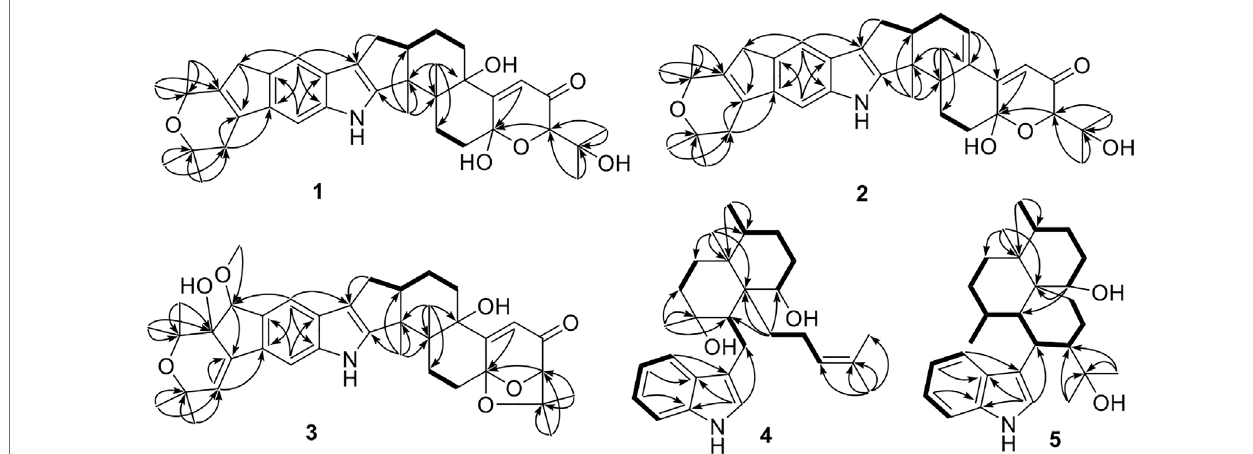
FIGURE 2 | Selected HMBC and COSY correlations of 1 – 5 .